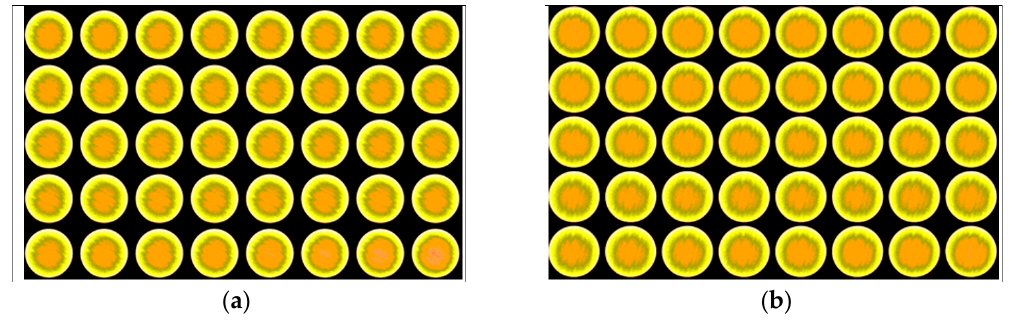
Figure 9. CT scan slices through the core (2” thickness and 2.5” diameter) where ( a ) shows the core before filtration and ( b ) shows the core after the filtration.